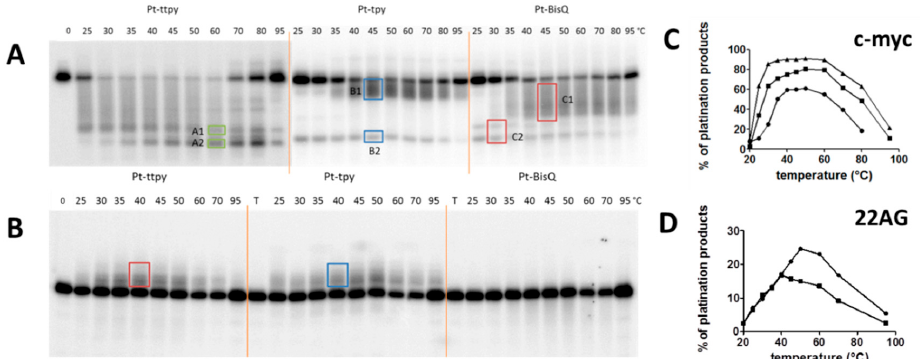
Figure 2. The denaturing gel of the platination reactions of ( A ) c-myc and ( B ) 22AG (0.2 µM) in the presence of Pt-ttpy (square), Pt-tpy (triangle), and Pt-BisQ (circle) (1 µM, 5 eq) and the quantification of the platination products for ( C ) c-myc and ( D ) 22AG were conducted under FRET-melting conditions: A temperature gradient of 25 ◦ C for 5 min and then 0.5 ◦ C/min up to 95 ◦ C using K + 1 and K + 10 buffers, respectively. An example of the quantified platination products are highlighted in both ( A ) and ( B ) by colored